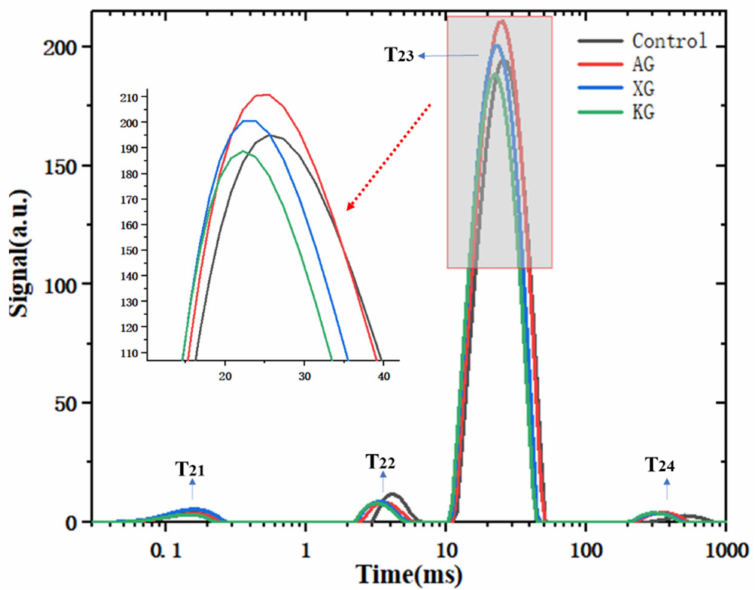
Figure 5. Relaxation time distribution for ink samples with different formulation at gum concentra- tion of